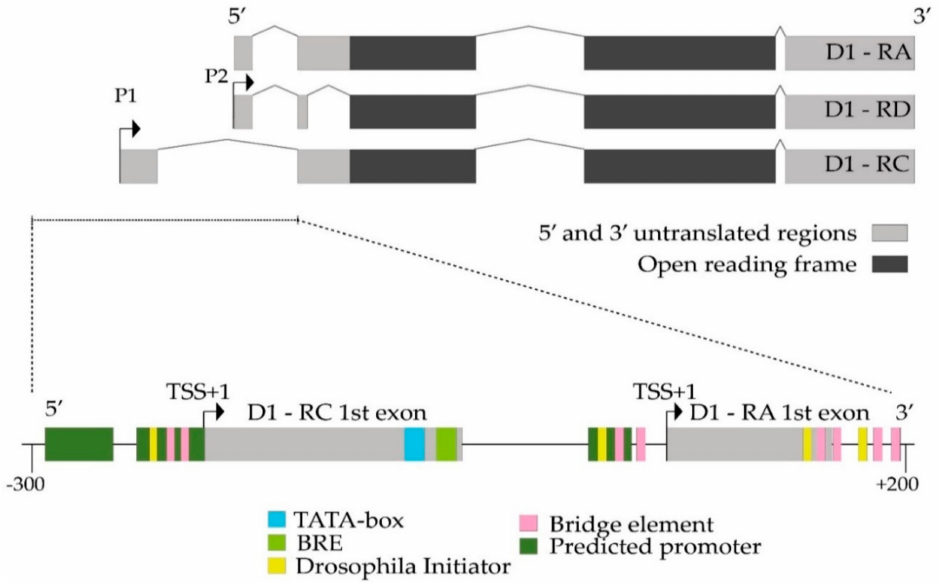
Figure 4. Analysis of putative promoter regulatory elements in Drosophila melanogaster D1 gene promoter region. (Upper panel) schematic D1 gene structure, showing the position and approximate size of exons, introns, and open reading frame in di ff erent splice variants according to Flybase. The sequence chosen for bioinformatic analysis performed as described in materials and methods is underlined. Two di ff erent promoters involved in transcription regulation of D1 gene designated as P1 and P2. (Lower panel) schematic results of bioinformatic analysis of putative promoter regulatory elements in D1 promoter. TSS + 1—transcription start site (TSS). − 300—the distance upstream of D1—RC TSS. + 200—the distance downstream of D1—RA and D1—RD TSS. BRE—the B recognition